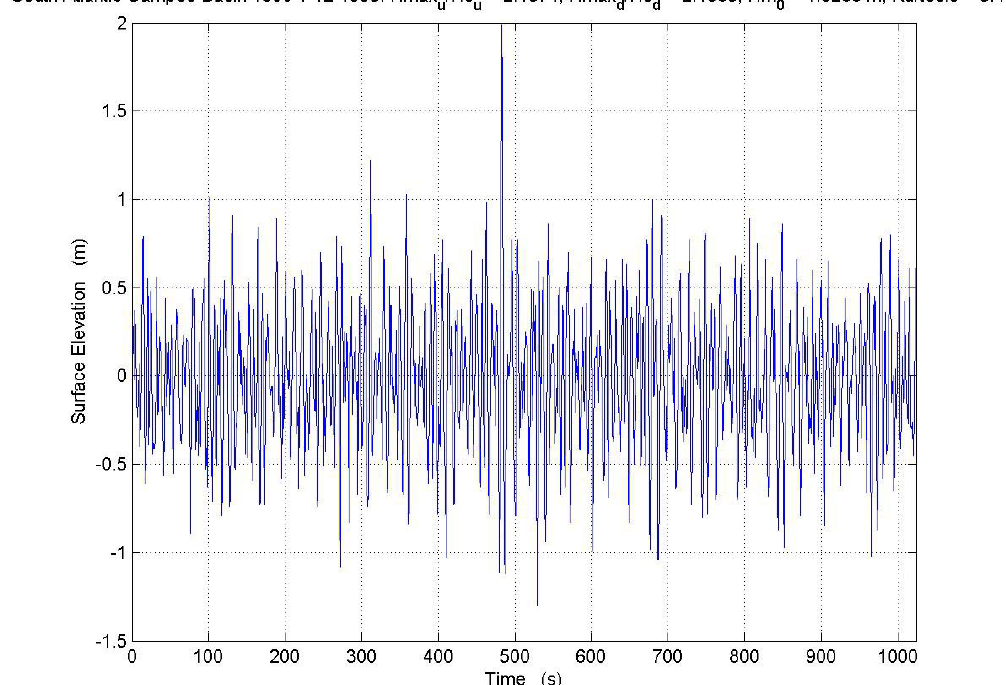
Figure 2. An example of Draupner-like freak wave time series data recorded in Campos Basin, South Atlantic Ocean, by a heave-pitch-roll buoy moored in over 1000 m depth.